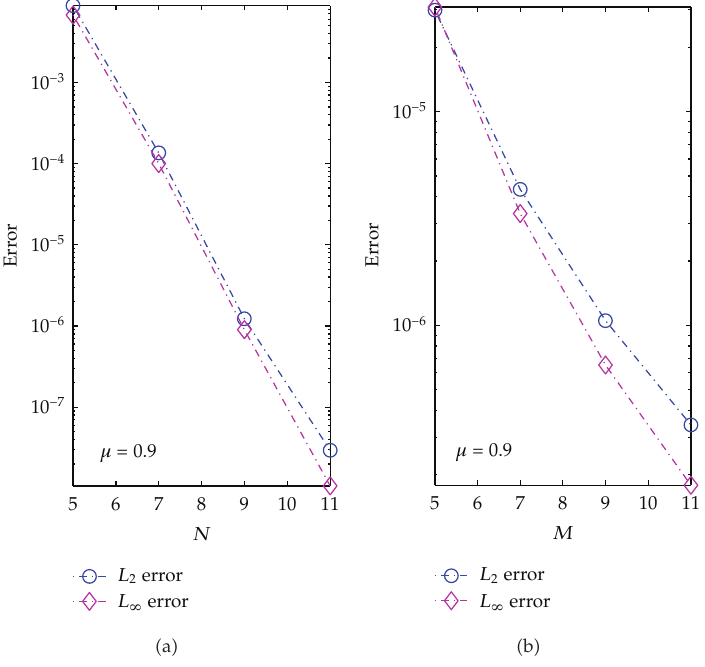
Figure 8: y -axis is log scale. (cid:4) a (cid:5) Errors versus N with M (cid:6) 16 ,μ (cid:6) 0 . 9. (cid:4) b (cid:5) Errors versus M with N (cid:6) 16 ,μ (cid:6) 0 .